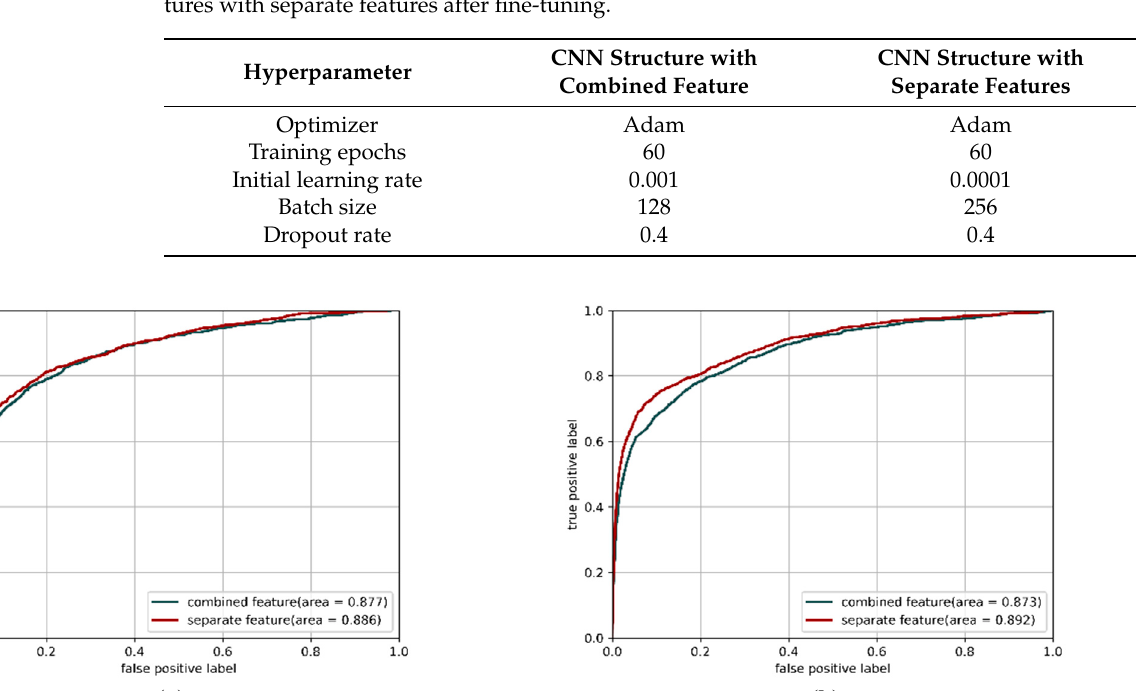
Table 5. The optimal hyperparameters for CNN structures with combined feature and CNN struc- tures with separate features after fine-tuning.